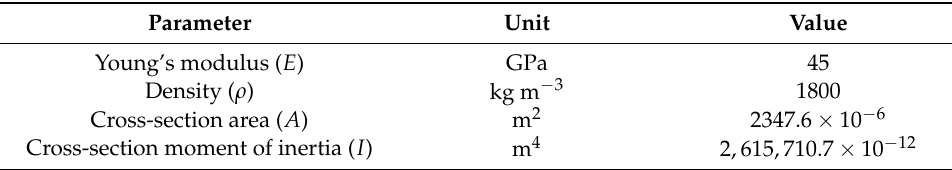
Figure 6. Scheme of the PE patch attached to the slat skin. Table 1. Mechanical properties of the slat.